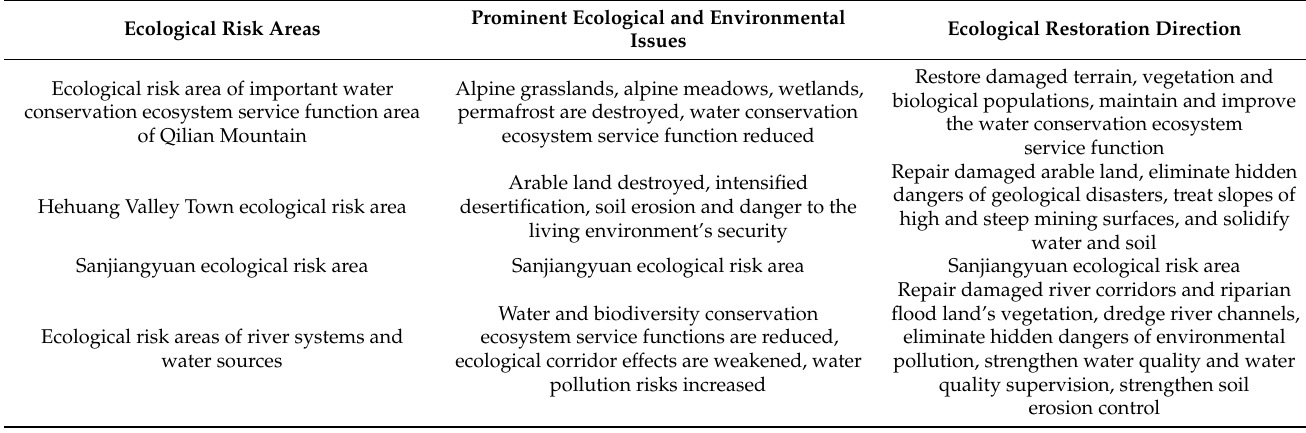
Figure 9. Distribution map of mines’ ecological restoration models. Table 5. Direction of mines’ ecological